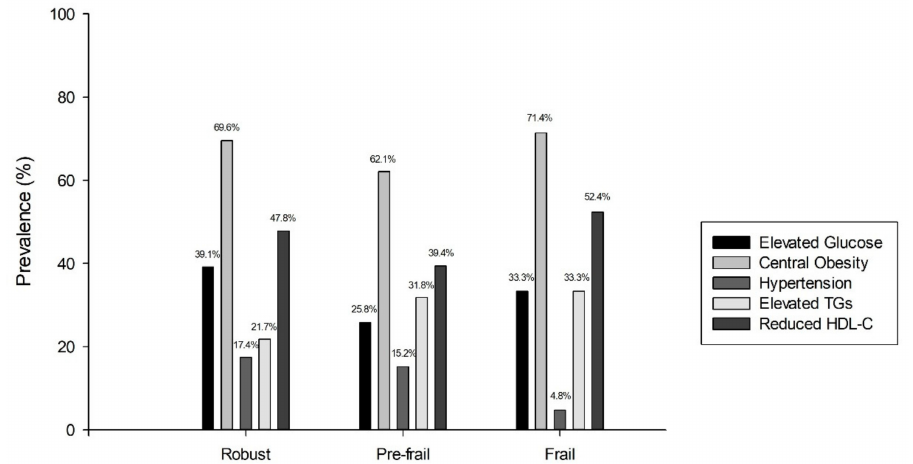
Figure 1. Prevalence of MetS cardiometabolic risk factors by frailty group. HDL-C, high-density lipoprotein cholesterol; TGs, triglycerides.